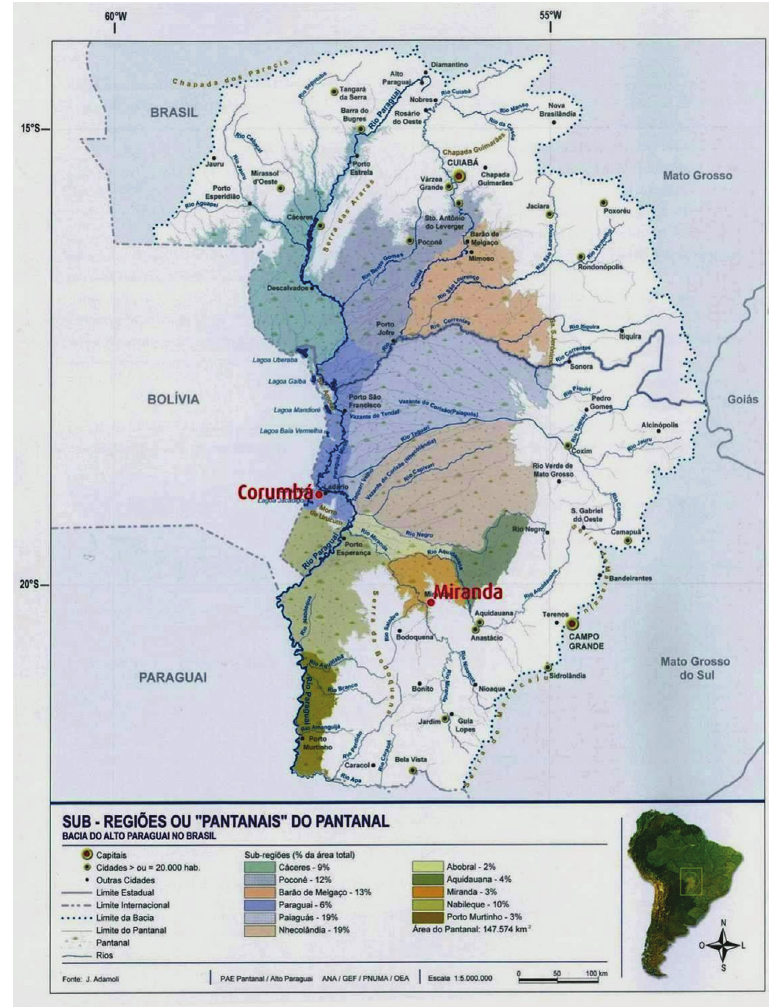
Figura 2 - The Pantanal region, in the Upper Paraguay River Basin (Mato Grosso do Sul and Mato Grosso States), with indication of the study area - Corumbá and Miranda towns. ANA, GEF, PNUMA, OEA